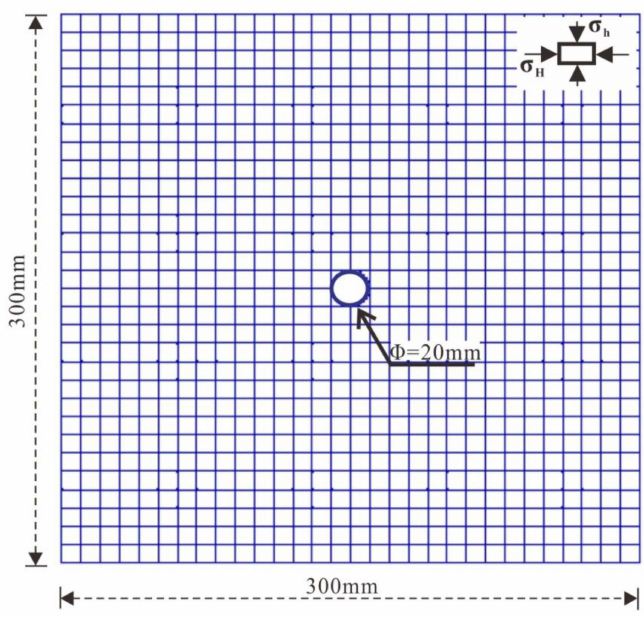
Figure 2. Numerical model.